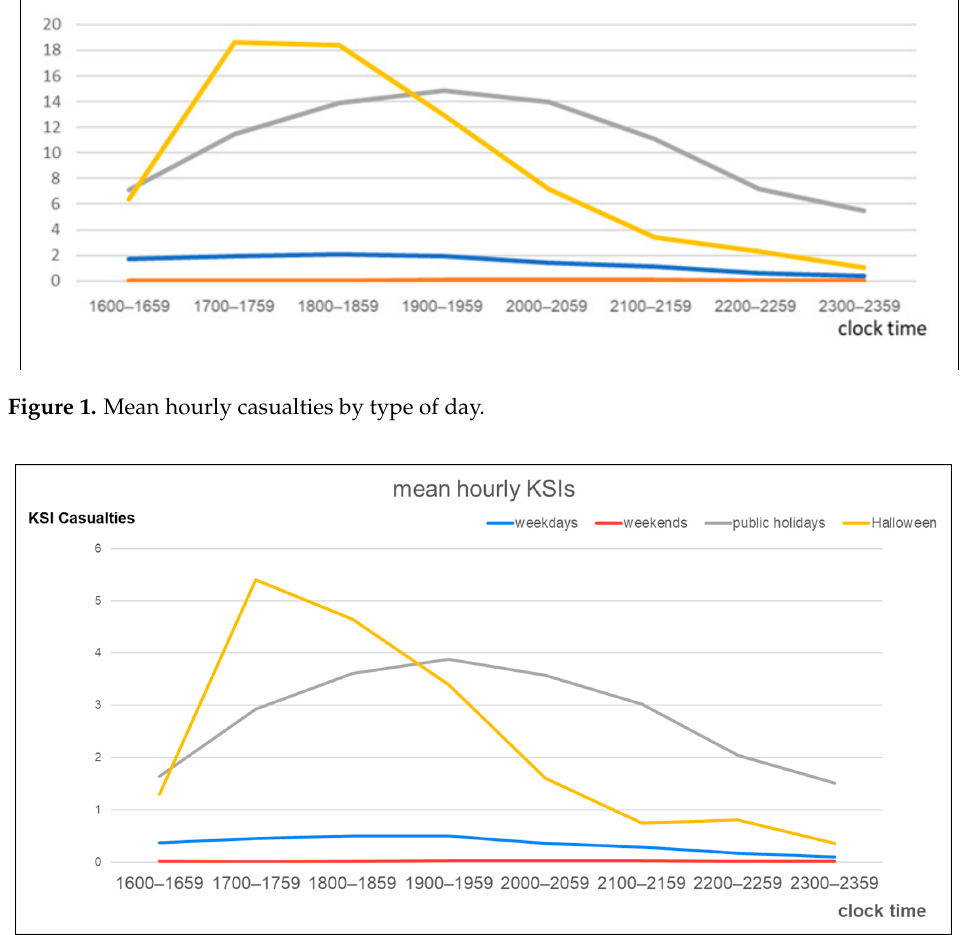
Figure 2. Mean number of hourly KSIs by type of day. Table 2. Distribution of injury severity by risk factor during 1990 to